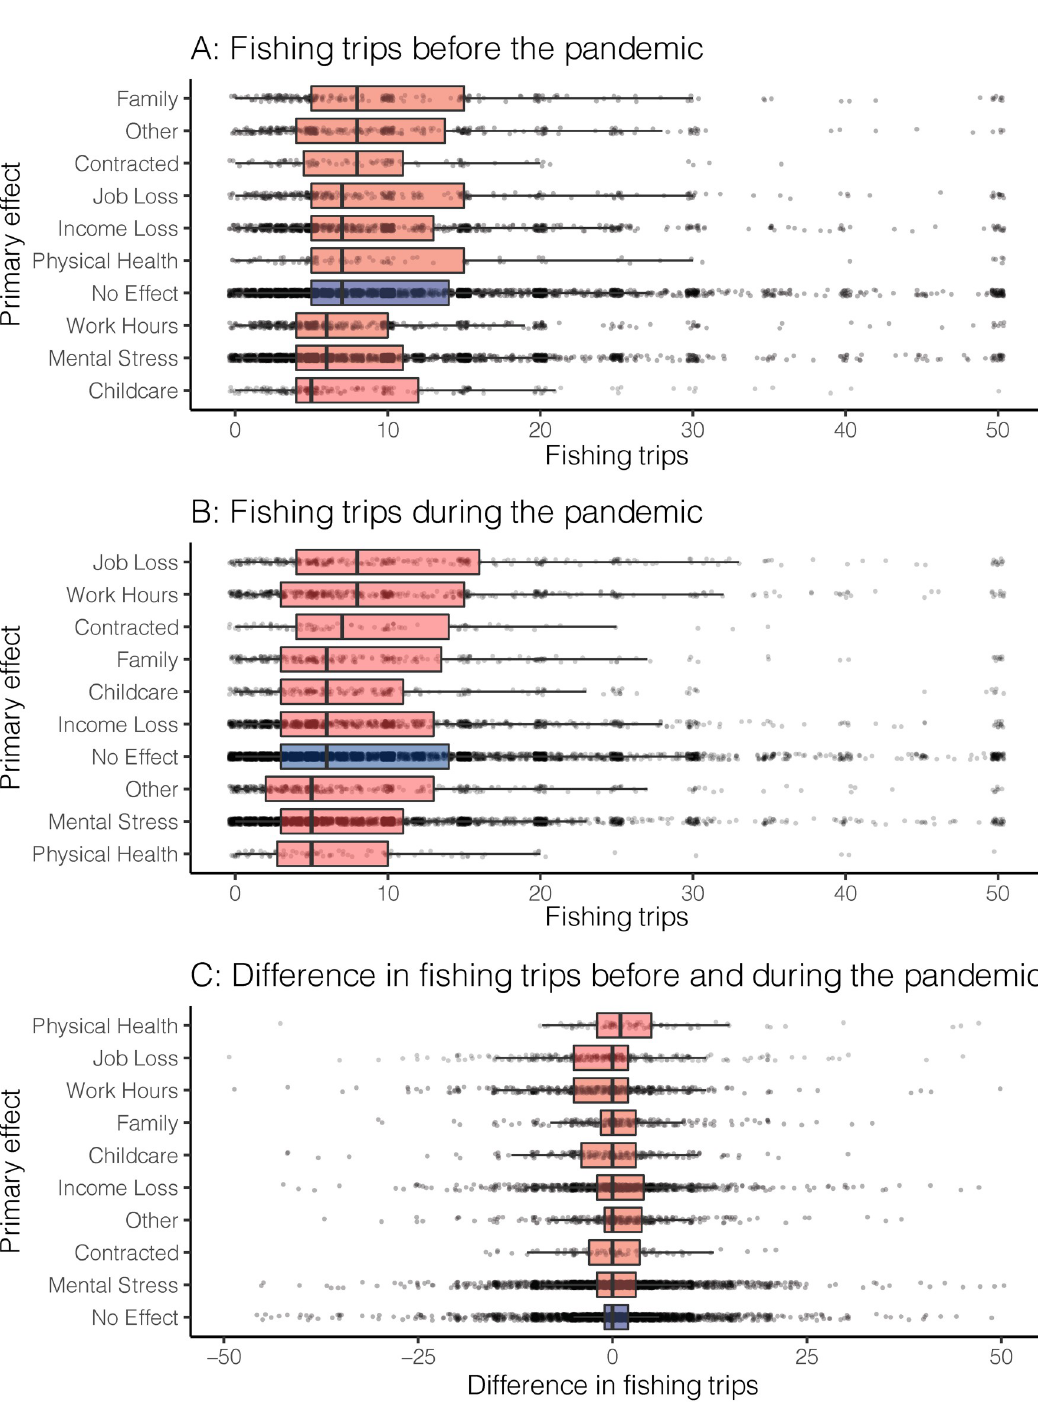
Fig 3. Boxplots of fishing trips grouped by primary effect of the pandemic. Fishing trips before (panel A) and during (panel B) the pandemic, along with the difference in fishing trips (panel C) are broken down by angler’s primary reported effect. Individual responses are shown in jittered gray dots (which overlap to appear black), and boxplots are shaded red or blue to simply distinguish between primary effects (red) and no effect (blue). Boxplot are ordered by the mean number of trips, with the most trips in the top box and least trips in the bottom